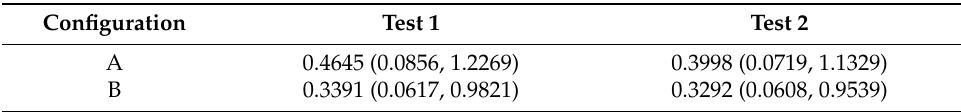
Table 5. Median distance of particle centroid to epipolar line in px (between brackets, the 10th and 90th percentile are given).